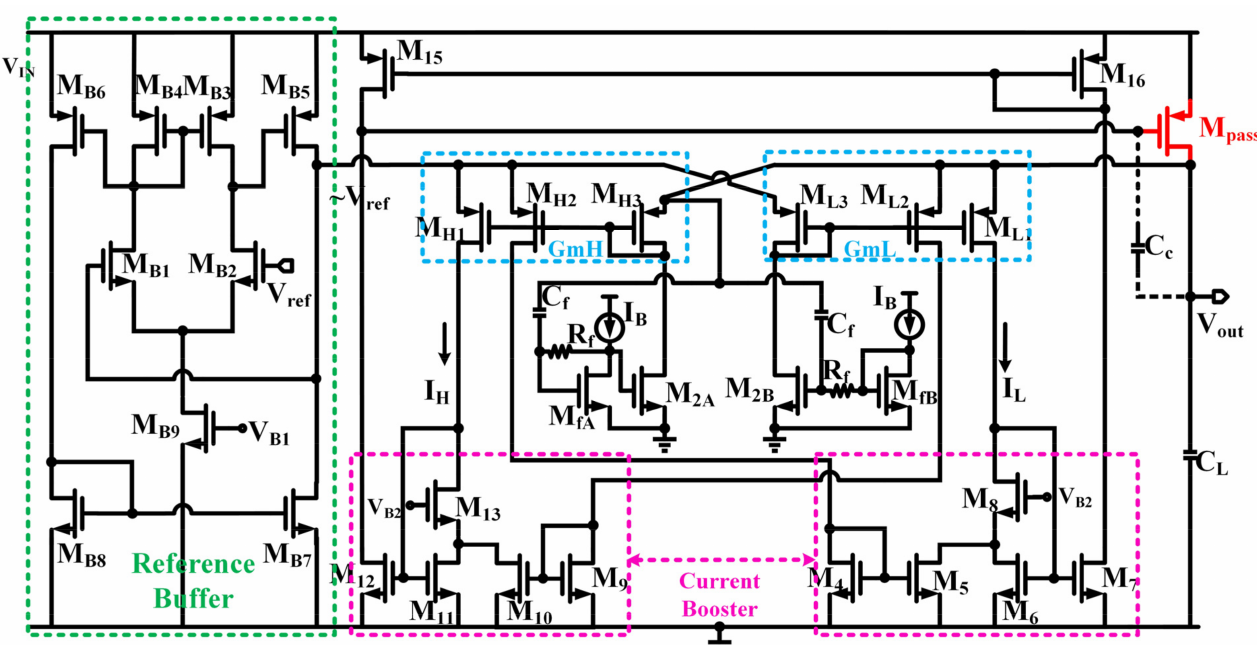
Figure 6. Transistor level schematic of the proposed